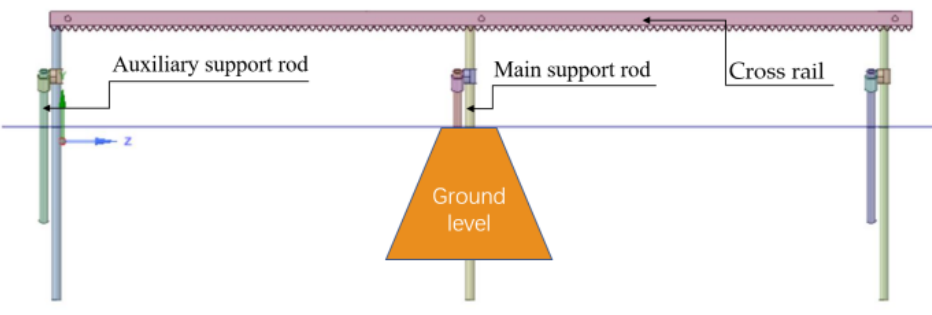
Figure 2. Statics analysis model diagram of the track system. Table 2. Materials and properties.